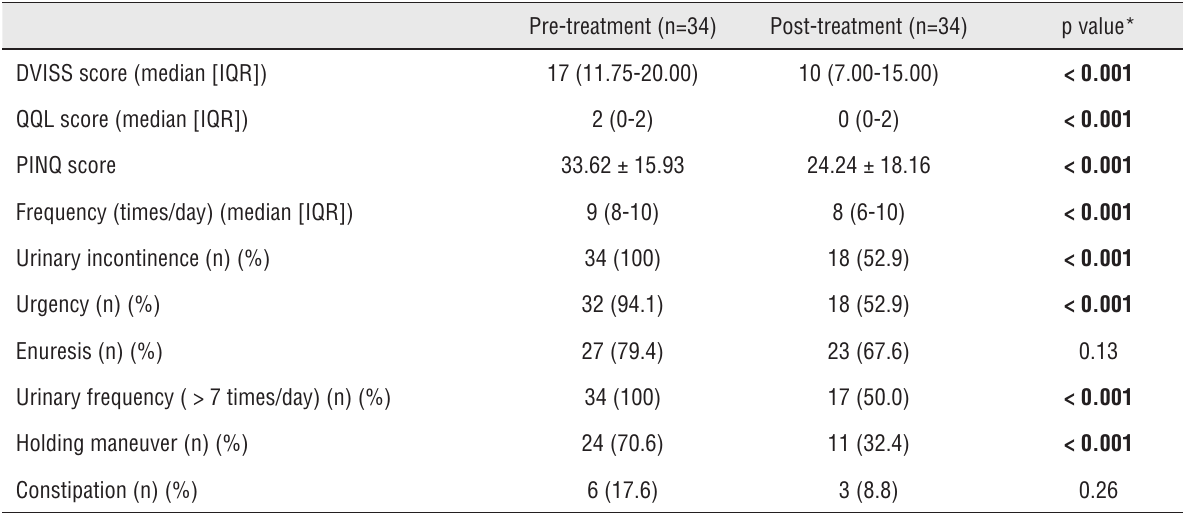
Table 2 - Effect of vitamin D supplementation on urinary symptoms and quality of life in patients who completed the follow-up